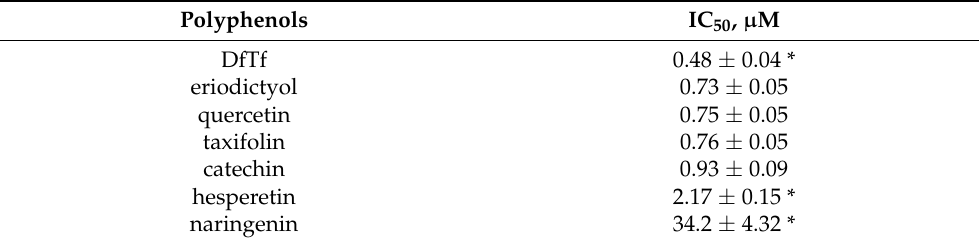
Table 1. Polyphenol concentrations necessary for the 50% inhibition of chemiluminescence (IC 50 ).